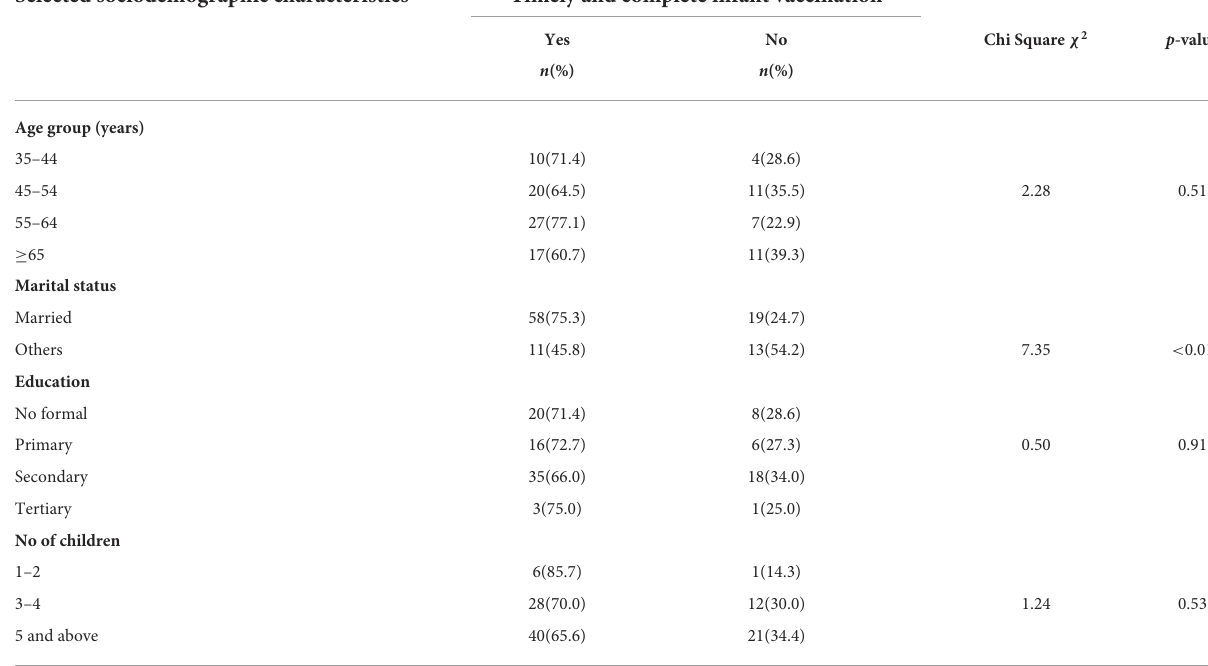
TABLE 4 Relationship between selected older women caregivers’ socio demographic characteristics and overall timeliness and completeness of infant vaccination in urban slum communities of Ibadan, Nigeria.